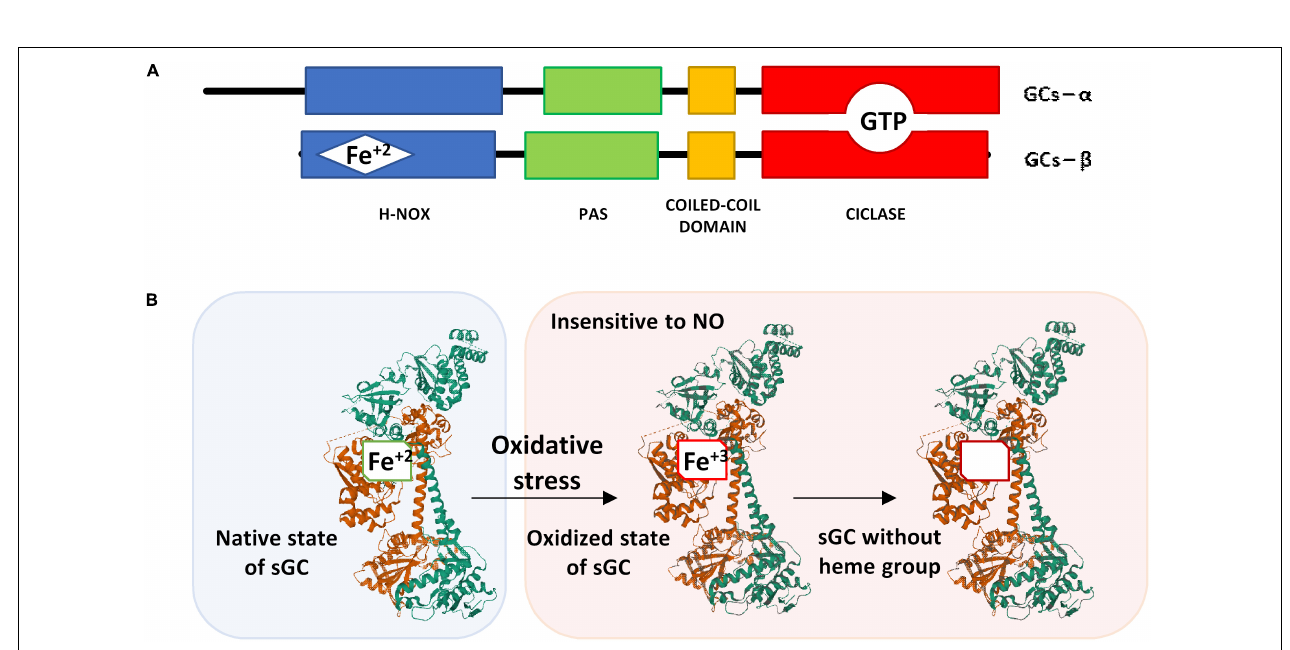
FIGURE 2 | (A) Schematic representation of the α and β subunits of sGC. (B) Structure of the native state of sGC in its inactive form (without NO binding) and its oxidized form after oxidative stress. The α 1 subunit is represented in green, the β 1 subunit that contains the heme group is represented in brown. The image of the sGC has been created with Mol*, RCSB PDB: 6JT0 (Kang et al., 2019).